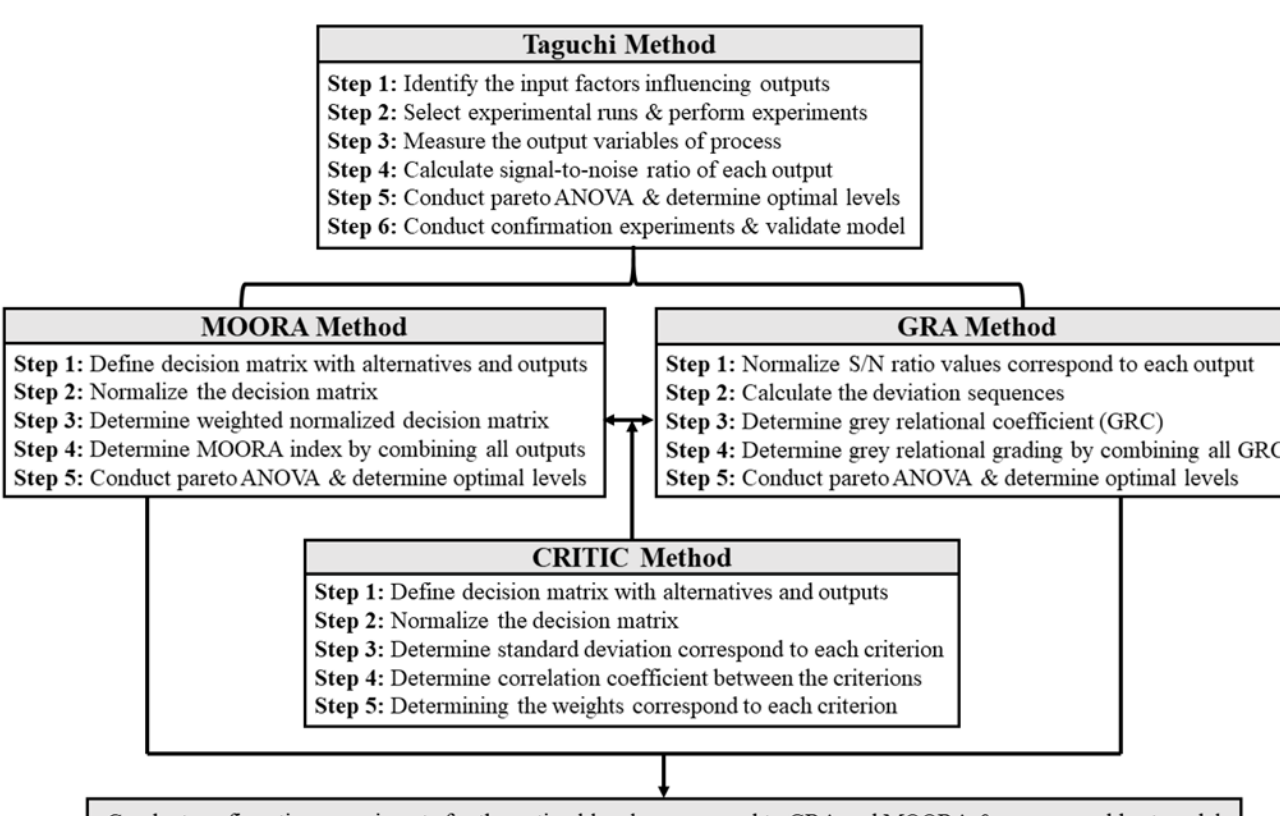
Figure 5. Framework of the hybrid approach to perform modeling and optimization.